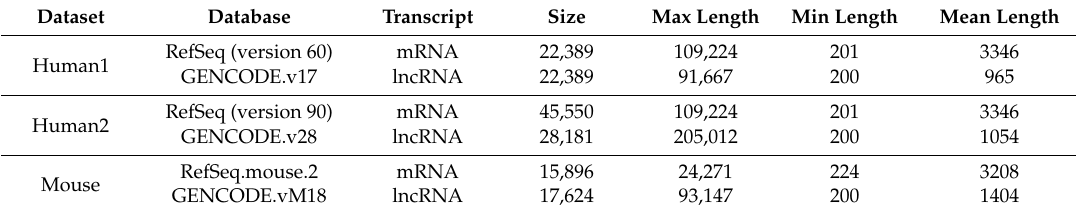
Table 1. Description of six datasets of mouse and human for lncRNA prediction.